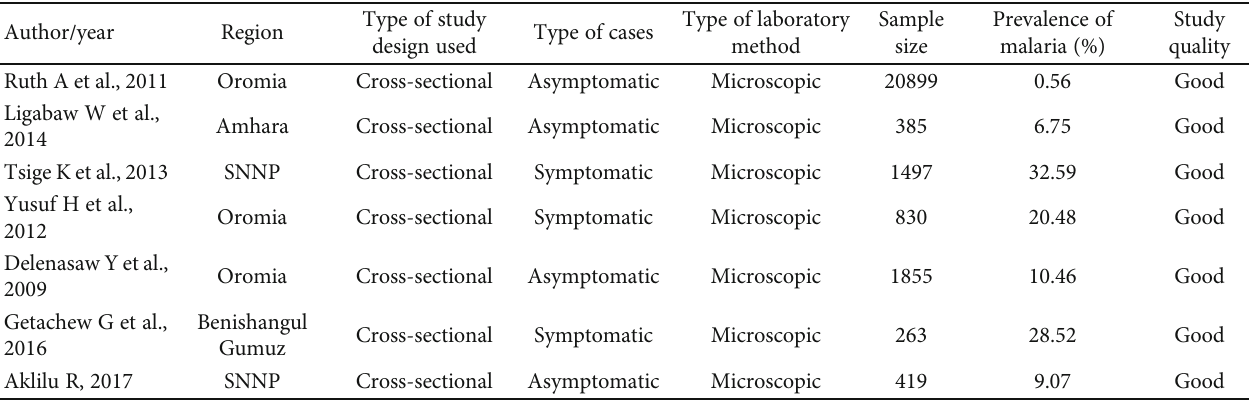
Table 1: The included studies general characteristics in the systematic review and meta-analysis of the prevalence of malaria among children in Ethiopia, 2020.